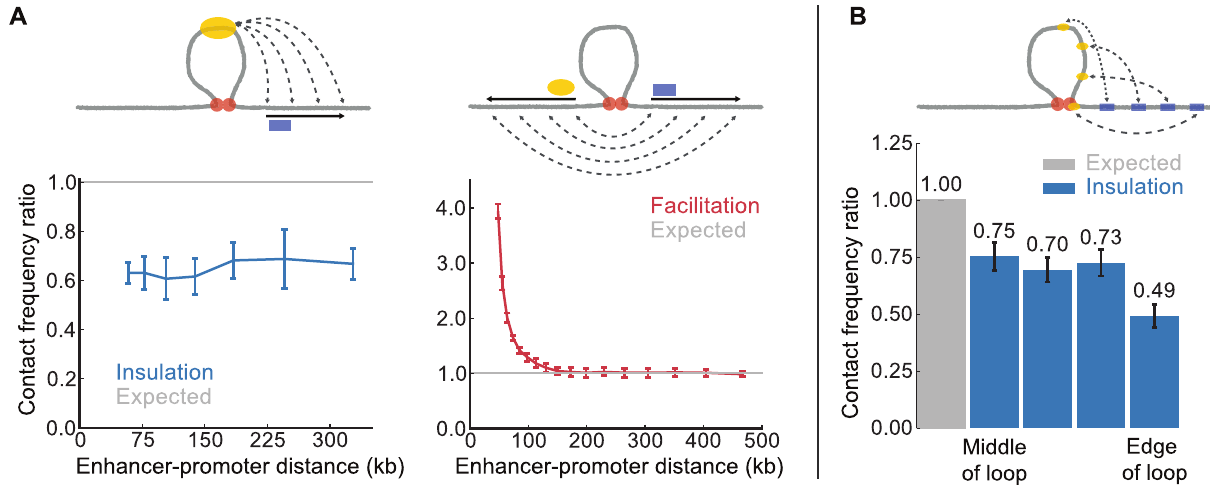
Figure 3. Insulation and facilitation strength depends on enhancer-promoter positions. ( A ) Insulation ( left ) and facilitation ( right ) as a function of E-P genomic distance. For insulation, enhancer position remains fixed. For facilitation, an E-P pair is positioned symmetrically around the loop at each genomic distance. ( B ) Insulation for different positions of the enhancer within the loop with a constant genomic distance of 50 kb.